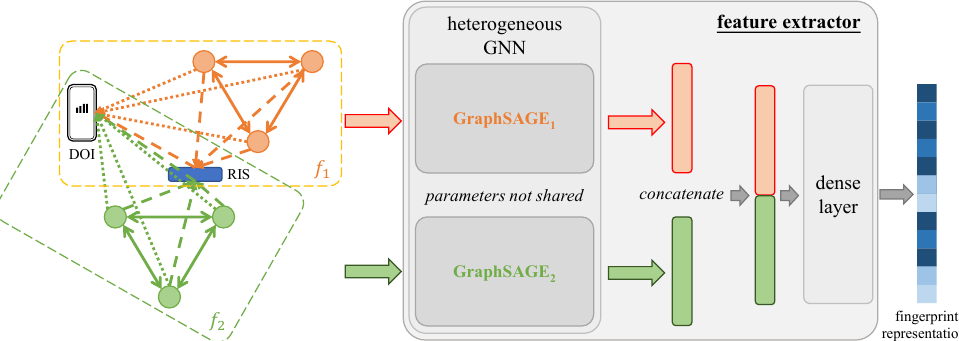
Figure 12. The feature extractor for the fingerprint graphs from Figure